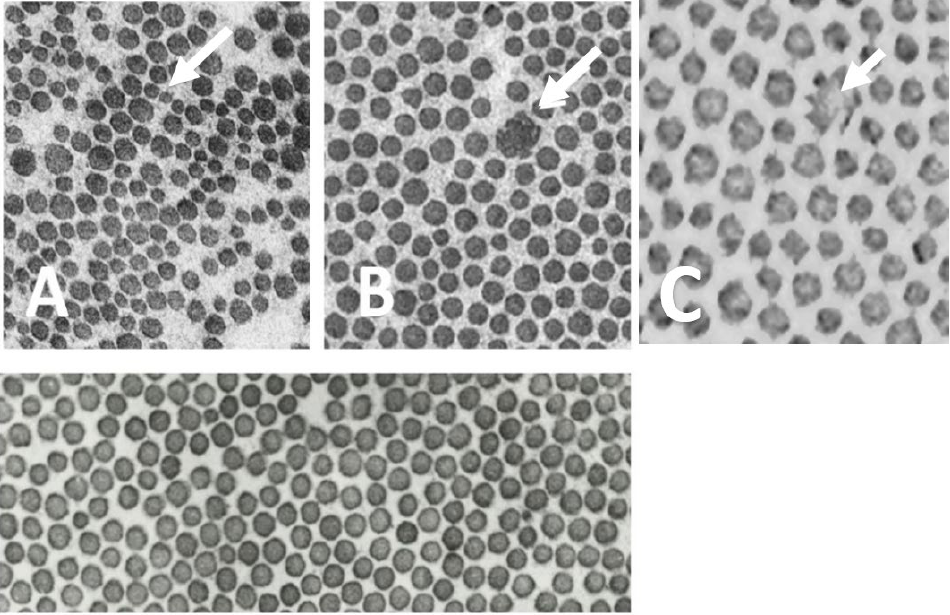
Figure 1. Electron microscopy of collagen fibers from skin biopsies from patient 2 ( A ), patient 3 ( B ) and patient 4 ( C ) and a healthy control individual (lower panel). Arrows indicates composite collagen fibrils. Collagen fibrils are aberrative and different in diameter. Magnification: 40,000×.